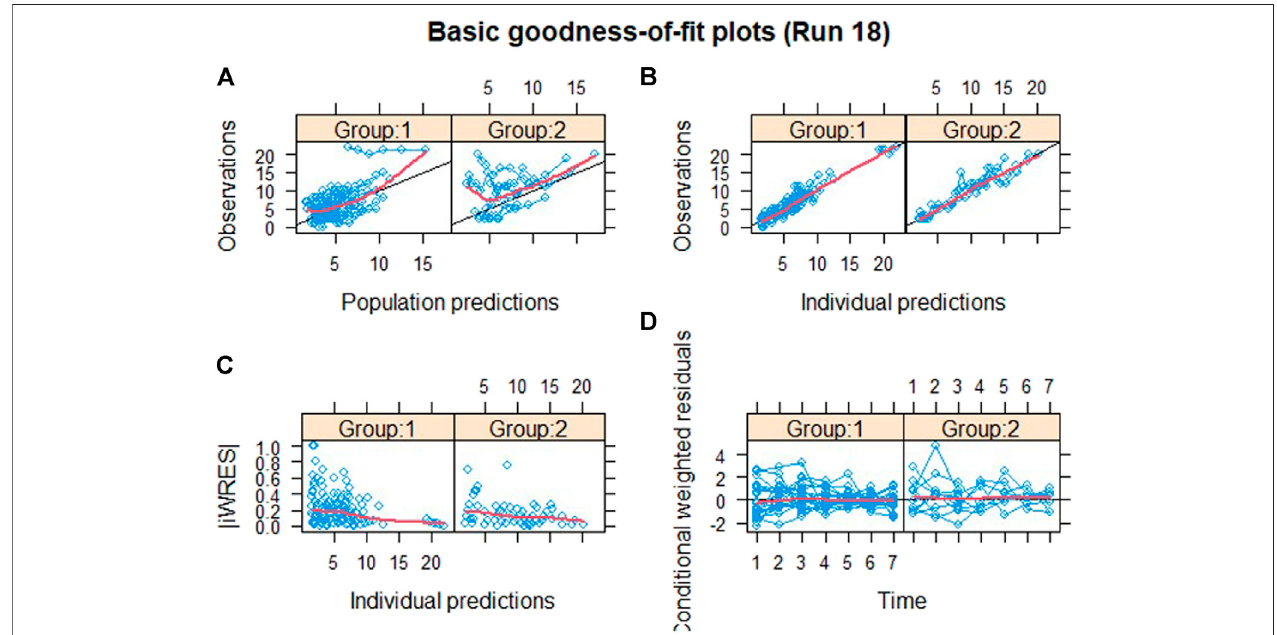
FIGURE 1 | Goodness-of- fi t plots. Group 1: the drug group; Group 2: the placebo group; (A) population predictions vs. observation. (B) Individual predictions vs. observation. (C) Individual predictions vs. absolute of individual weighted residuals and (D) conditional weighted residuals vs. time. The black solid lines in (A) and (B) represent the line of identity and that in (D) represent the line y (cid:2) 0. The red solid lines in each panel represent the Loess smooth curve of the data.